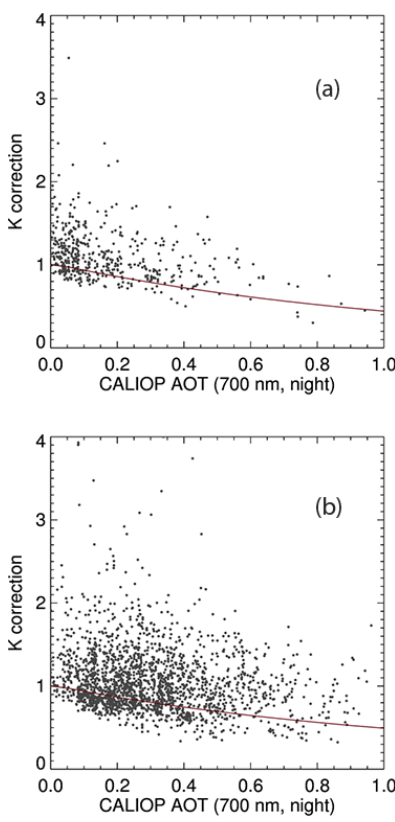
Figure 11. (a) Empirically derived (using data from Fig. 7d; filled circles) and 6S-model-estimated (red line) diffuse correction terms for the Middle East for 2015. Panel (b) is similar to Fig. 11a but for the Indian region for 2015 (using data from Fig.